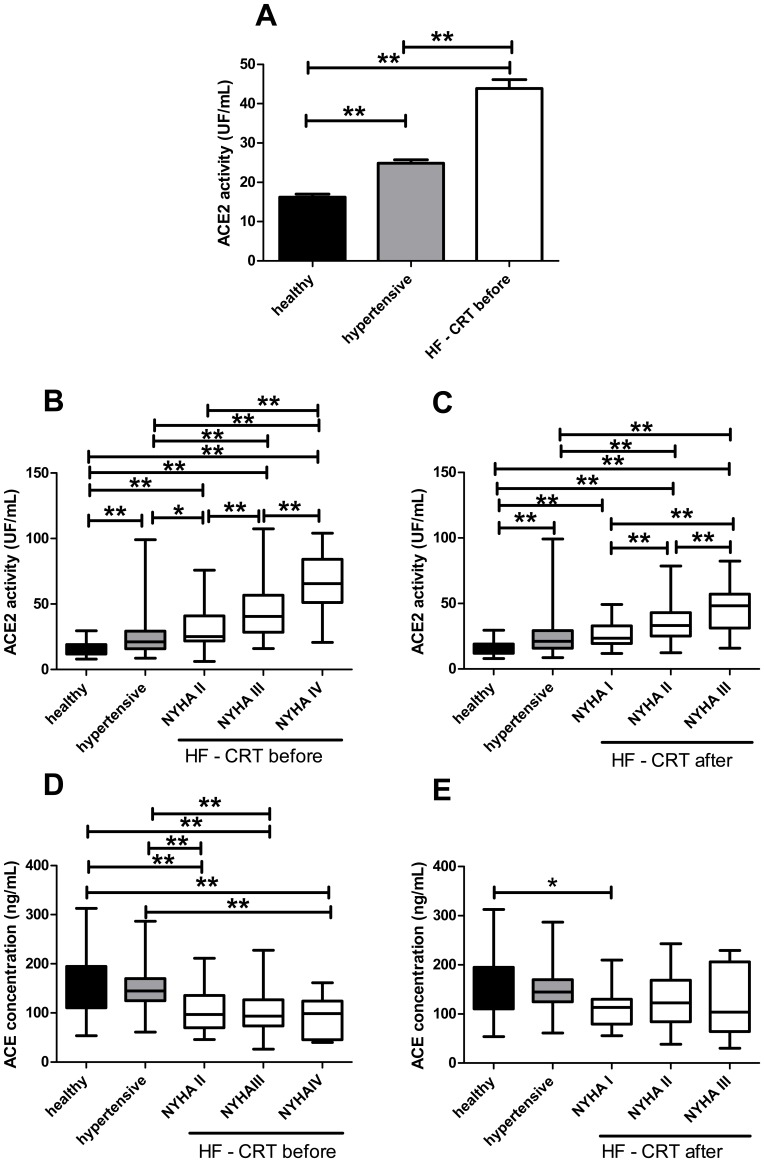
Differences in serum angiotensin converting enzyme activities and concentrations in study populations representing various clinical status of heart failure.Serum ACE2 activity levels were determined in healthy people (healthy, n = 45, filled bar, panel A), patients with no apparent heart failure (hypertensive, n = 239, grey bar, panel A) and in patients with severe systolic heart failure (HF - CRT before, n = 100, open bars, panel A). Patients were also evaluated with respect of their New York Heart Association (NYHA) functional class (HF - CRT before: NYHAII: n = 31; NYHAIII: n = 55; NYHAIV: n = 14, panel B; HF - CRT after: NYHAI: n = 17; NYHAII: n = 37; NYHAIV: n = 11, panel C). Serum ACE concentration was also determined with respect of the New York Heart Association (NYHA) functional class of the patients before (HF – CRT before, panel D) and after CRT (HF – CRT after, panel E). Statistical analyses of healthy people, hypertensive, HF - CRT before and HF – CRT after groups were performed by one-way analysis of variance (ANOVA) followed by Newman-Keuls test for multiple comparisons between groups. Bars are mean ± S.E.M. Significant differences are labeled by asterisks (** P<0.001).